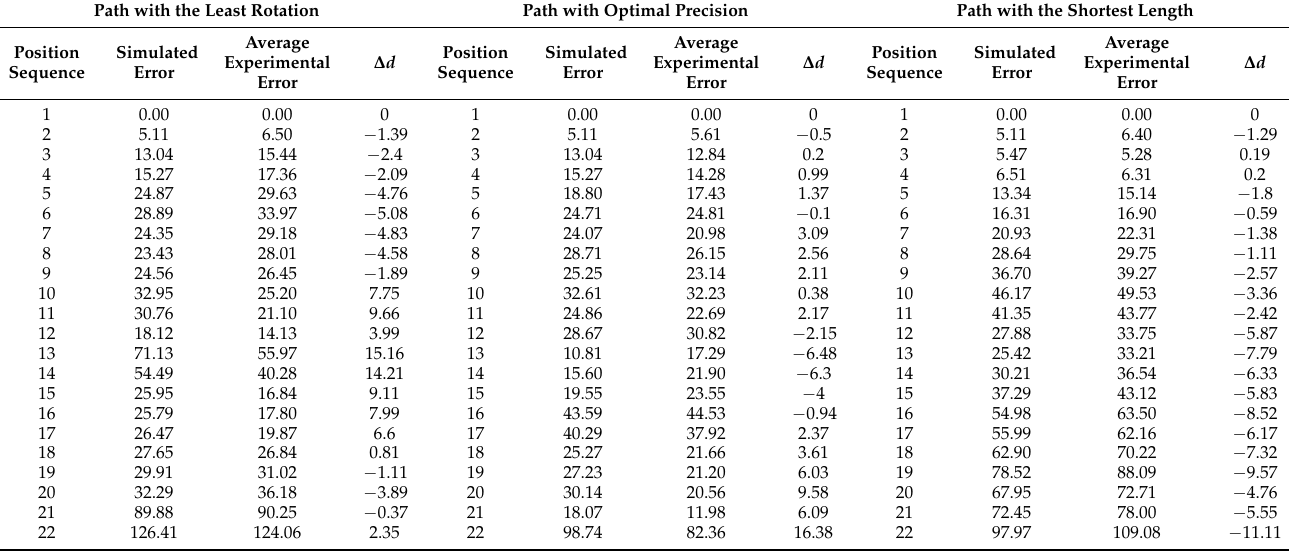
Table 2. Experimental validation of position error with proposed three-parameter error model (mm).